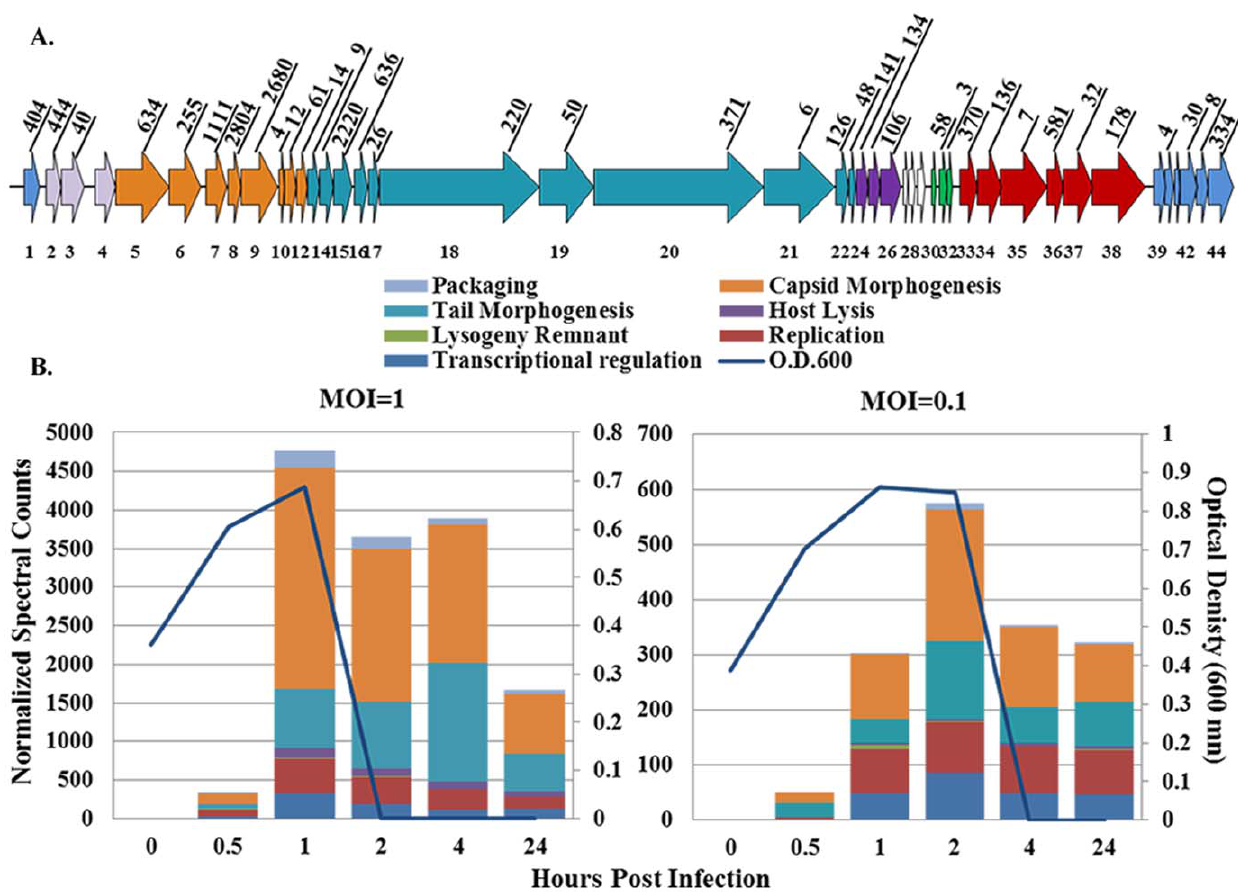
Figure 1. Phage 2972 spectral abundances. A.) Depiction of phage 2972, color coded according to functional modules. Each arrow represents an open reading frame and numbers on top are normalized spectral counts totaled across all MS runs at MOI=1. B.) Normalized spectral counts were added together at each time point of infection for MOI=1 (left panel) and MOI=0.1 (right panel). Optical density measurements (600 nm) (blue line) show cell lysis occurring immediately following the time points in which the highest numbers of phage spectra are detected at each MOI. Colors within each bar correspond to phage functional modules.